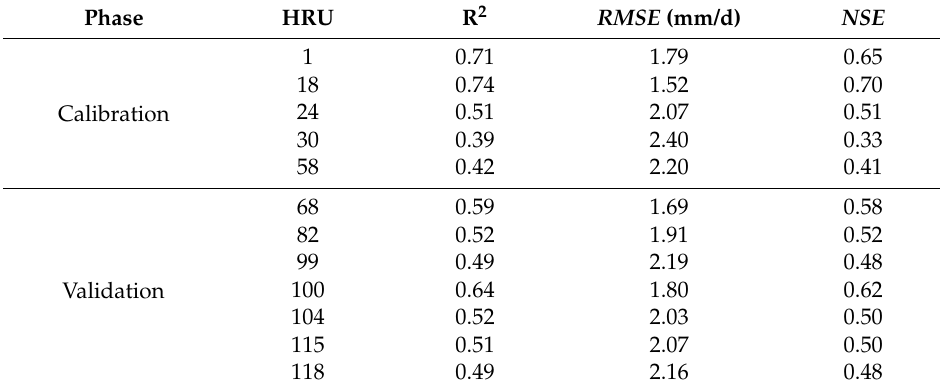
Table 10. Statistical parameters related to ET c in the calibration and validation phases.